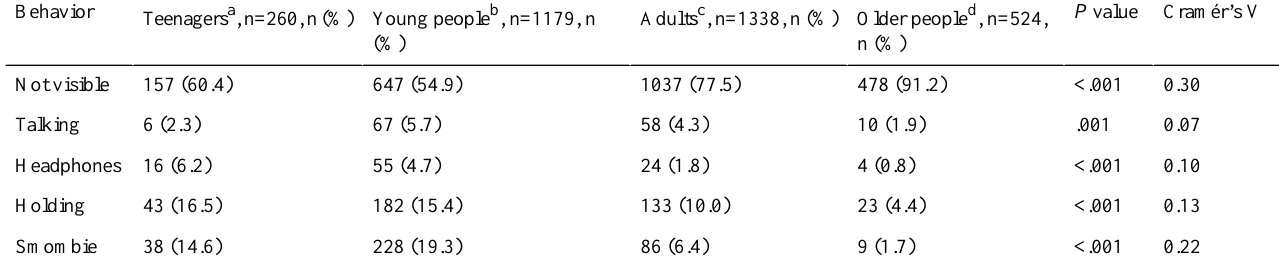
Table 3. Influence of age on smartphone usage behavior in